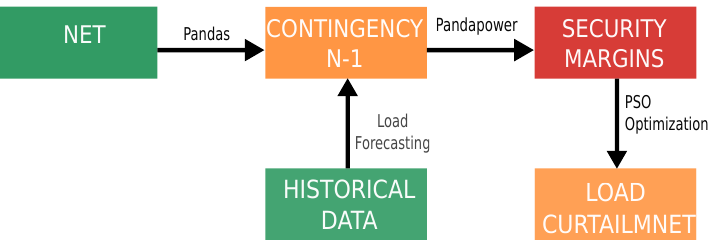
Figure 1. Proposed methodology for load curtailment optimization.